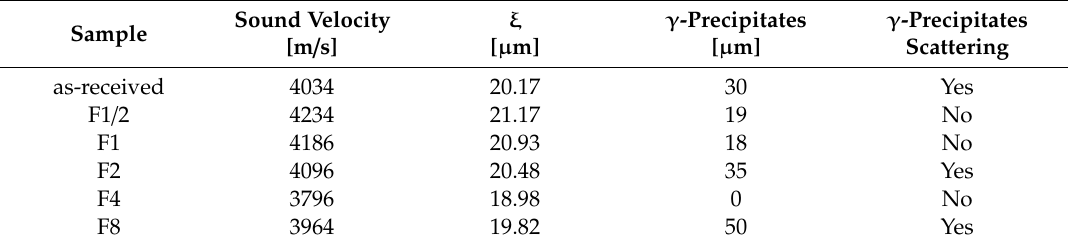
Table 4. Influence of austenite precipitates on the scattering regarding the ξ